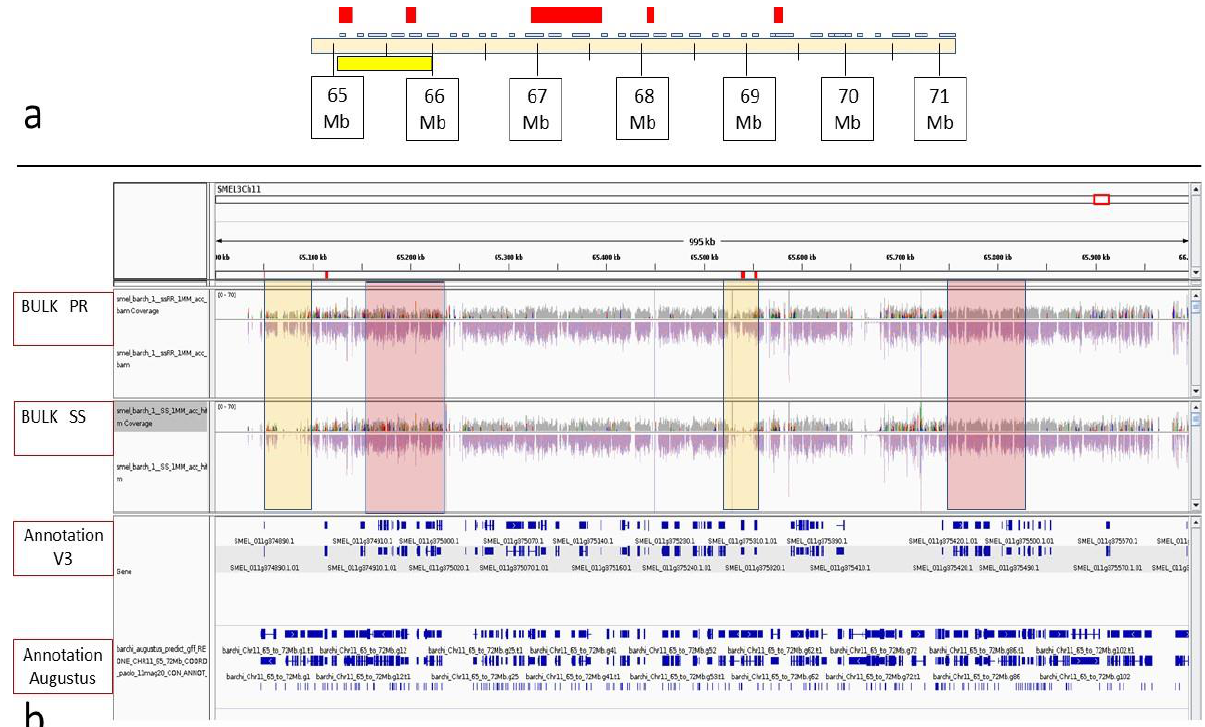
Figure 5. Example of IGV visual score in the region spanning 65 and 66 MB on chromosome 11. ( a ) In the upper panel, the region ranging from 63 – 71 Mb comprising within the CI of the FomCH11 QTL is represented. The yellow box depicts the region zoomed in the box below. The red boxes indicate the position of the 5 differentially enriched regions highlighted from BSA-seq analyses. ( b ) Read alignments of the two bulks PR (on the top) and SS (bottom) against the reference sequence of ‘67/3’ are shown, together with the annotated genes according to V3 genome sequence ([35], top ) and the additional Augustus annotation ( bottom ), also including TE-related genes. The two yellow rectangles highlight two differentially enriched regions between bulks of PR and SS (i.e., with different read coverages detectable when comparing upper and lower panels), while the pink rectangles highlight the position of two non-enriched ones. Table 4. List of differentially enriched regions within the confidence interval of QTL FomCH11 . For each region, extension, number of annotated genes, number of genes annotated as resistance genes and details for each best candidate gene according to the annotation in eggplant genome V3 [35] are reported. Diff.